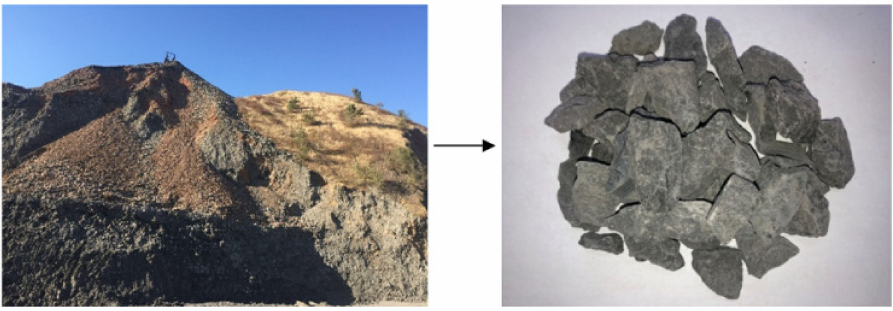
Figure 6. Undisturbed coal gangue [48].